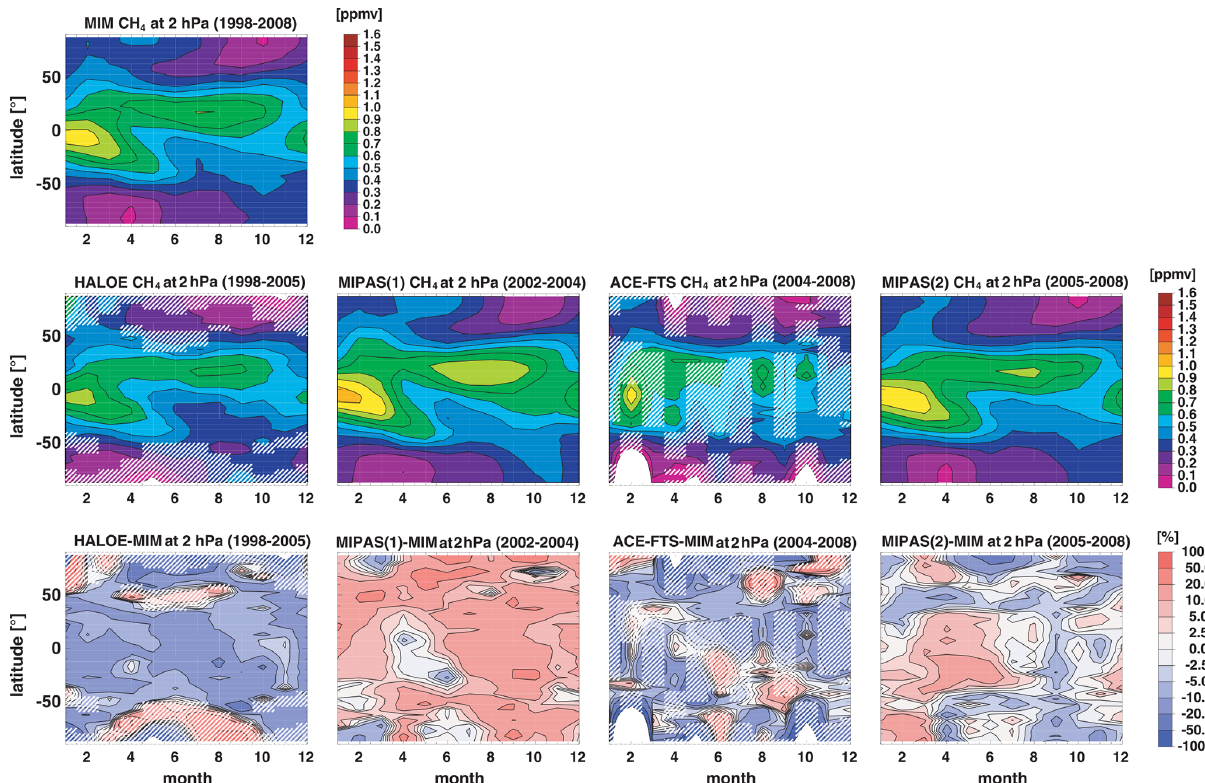
Figure 9. Latitude–time evolution of zonal monthly mean CH 4 at 2hPa and averaged over 1998–2008. Shown are absolute values for the MIM (top panel) and the different instruments (middle row), and for the relative differences with respect to the MIM (lower row). Note that HALOE and ACE-FTS show linearly interpolated fields, with hatched regions indicating where no measurements are